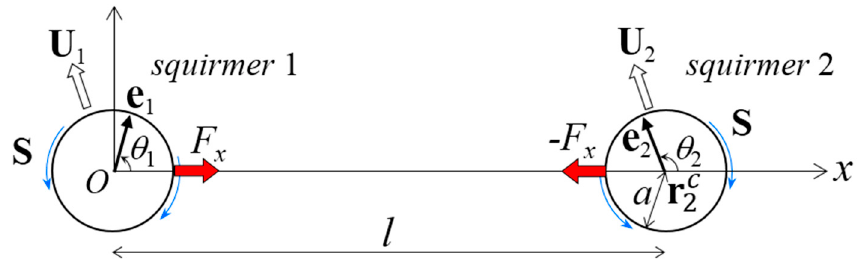
Figure 1. Problem settings for the far-field analysis. Two squirmers (1 and 2) with orientation vectors e 1 and e 2 , respectively, are shown in the far field. The center of squirmer 1 was placed at the origin of coordinate. We assumed that e 1 and e 2 were in the x–y plane, where the x -axis was taken as the direction passing through the center of squirmer 2 at 𝐫 (cid:2870)(cid:3030) (cid:3404) (cid:4666)𝑙,0,0(cid:4667) and l is the distance between the squirmer centers. This distance was assumed to be time-invariant with the application of x -direction force F x . No external torque was exerted; thus, the squirmer orientation was determined to satisfy the torque-free condition. The orientation angles θ 1 and θ 1 were defined from the x -axis. The radius of the squirmers was a , which satisfied l >> a . The squirmers swam with velocity U i , where i was 1 or 2, and exerted a stresslet of S .